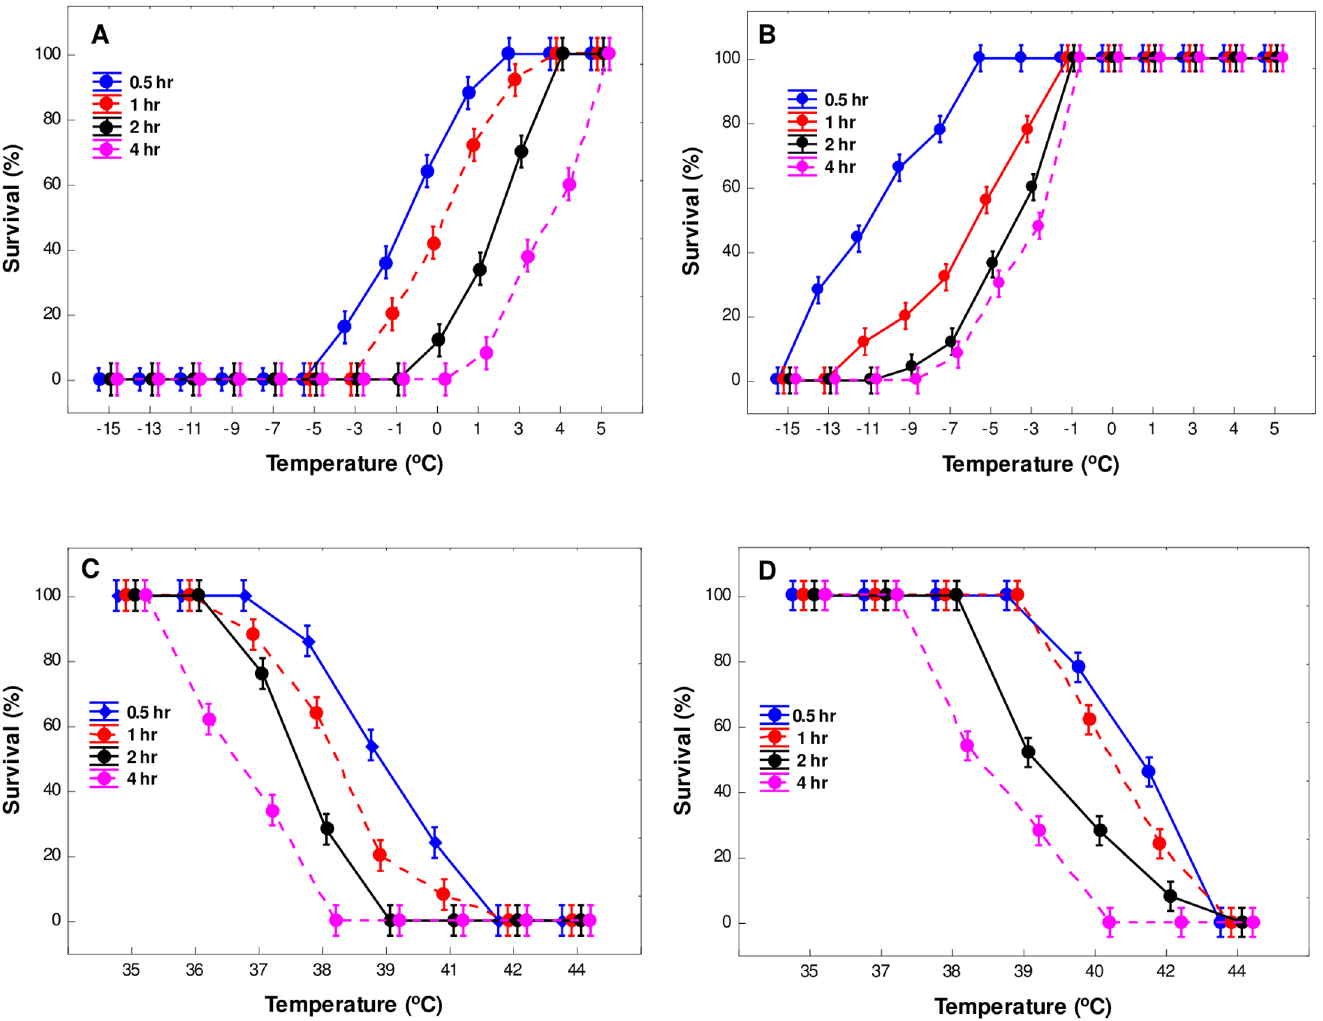
Fig 1. Mean ( ± 95% confidence limit) survival of (A) C . sesamiae and (B) C . flavipes at different low temperatures, and (C) C . sesamiae and (D) C . flavipes at different high temperatures applied over four different durations. n = 50 per each temperature/time treatment.